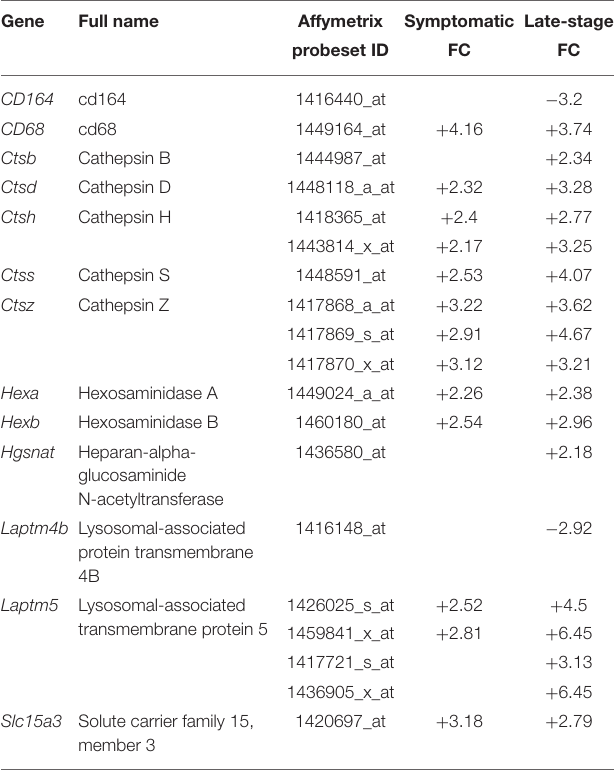
TABLE 2 | Lysosomal genes differentially expressed with p ≤ 0.05 and fold-change ≥ 2 in SOD1 G93A astrocytes vs. NTg controls. Gene